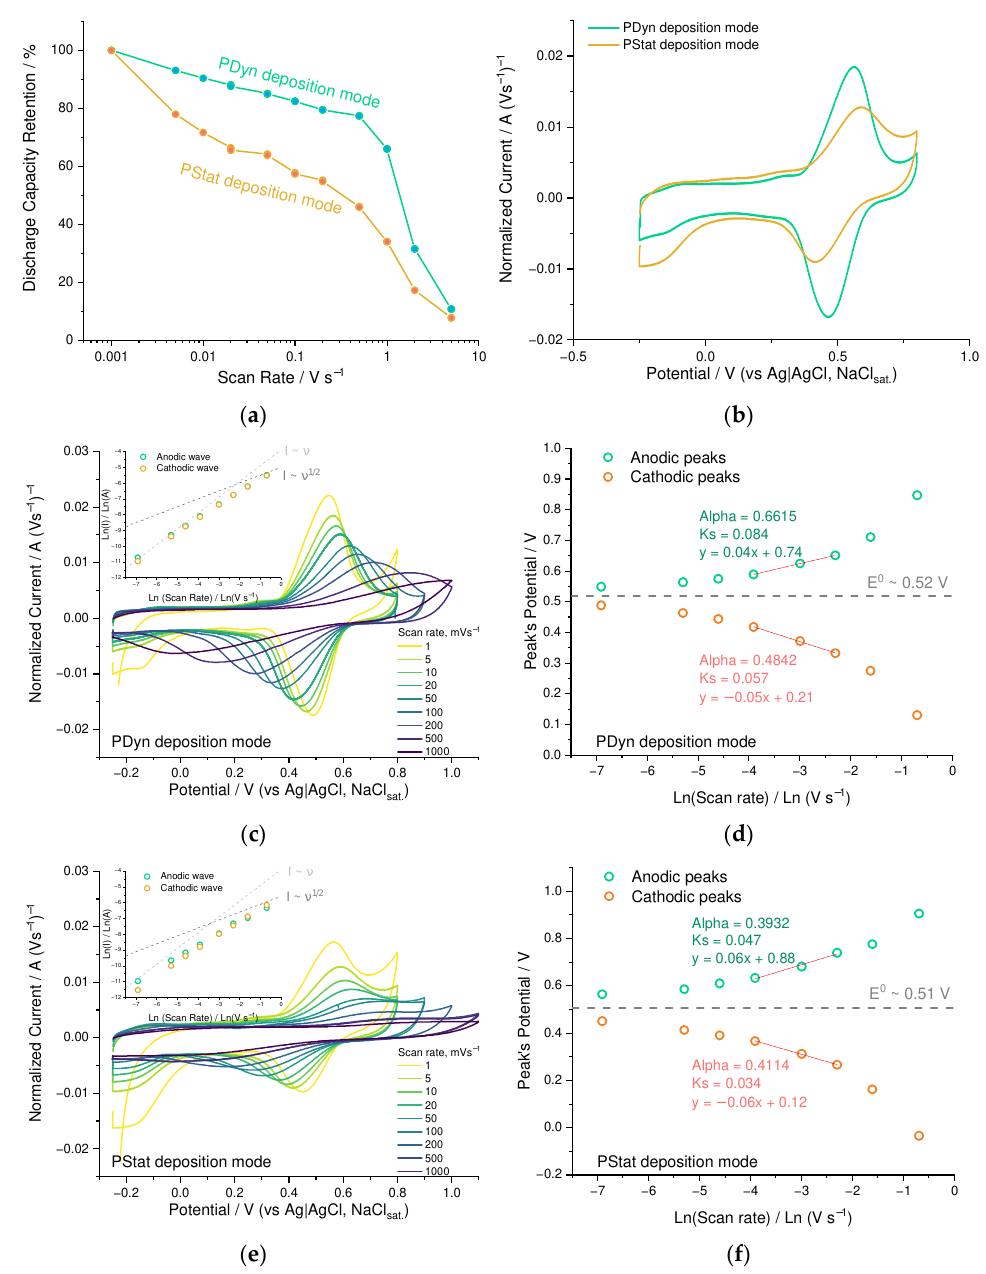
Figure 6. ( a ) Gravimetric capacity retention vs. scan rate and ( b ) CV curves (20 mV s −1 , 0.1 mM HClO 4 /H 2 O) for PDyn and PStat films; ( c , e ) CV curves at different scan rates (0.1 mM HClO 4 /H 2 O) of PDyn and PStat films, respectively (inset: dependence of peak current vs. scan rate); ( d , f ) dependence of peak potential vs. scan rate and rate constants for PDyn and PStat films, respectively. Higher peak separation (Figure 6b) indicates kinetic limitations of the charge trans- fer in PStat film. The nearly first-order relation between the logarithm of peak current and the logarithm of scan rate (insets, Figure 6c,e) also confirms the kinetics to be an overall limiting factor for the redox process of both PEDOT:SPVC films. Heterogeneous rate constants of the PDyn film calculated using the Laviron method (Figure 6d, k s = 0.084 s −1 for anodic peak and 0.057 s −1 for cathodic peak) were almost twofold higher than for